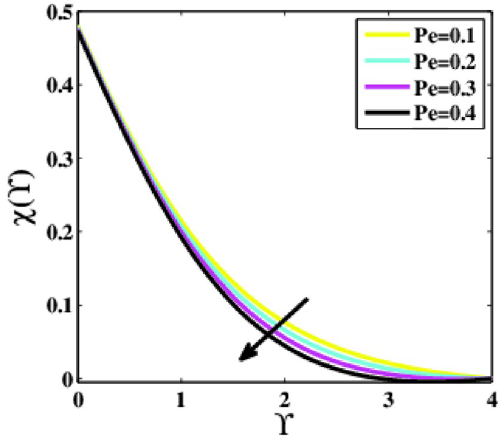
Figure 26. Plots of χ(ϒ) for Pe